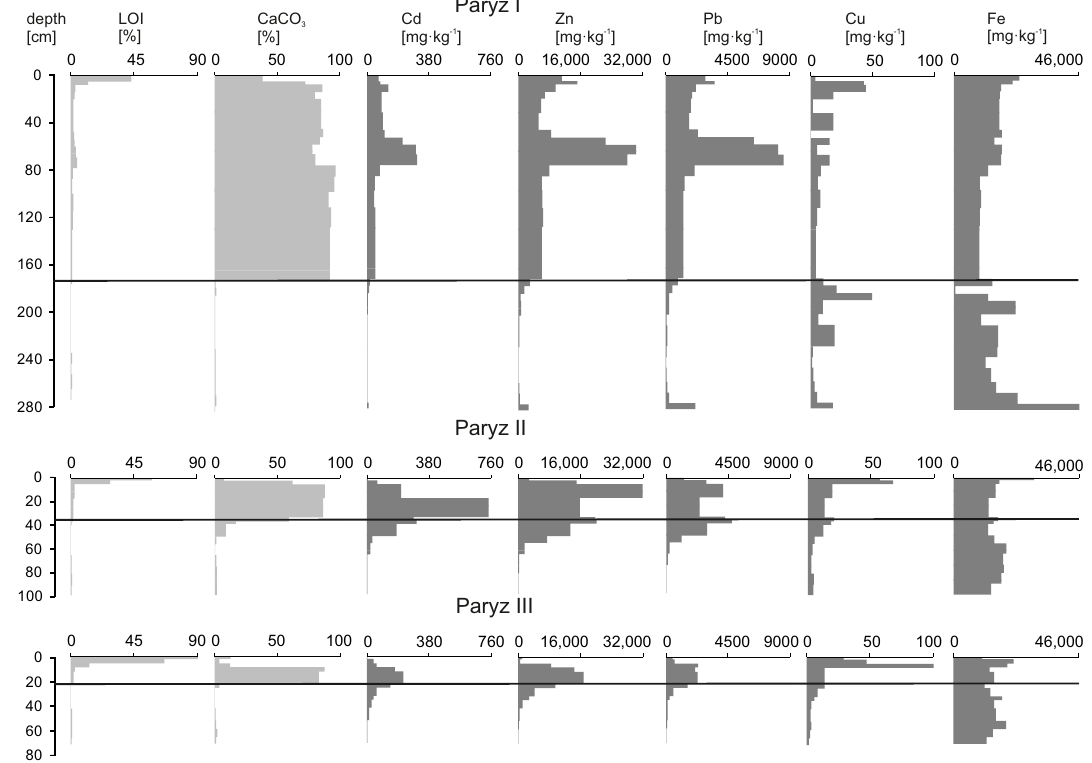
Figure 5. Distribution of selected elements in the profiles at the Paryz heap (lines show former soil level). Samples selected for analysis in the Lgota II profile (Figure 6a), resemble those of the Lgota